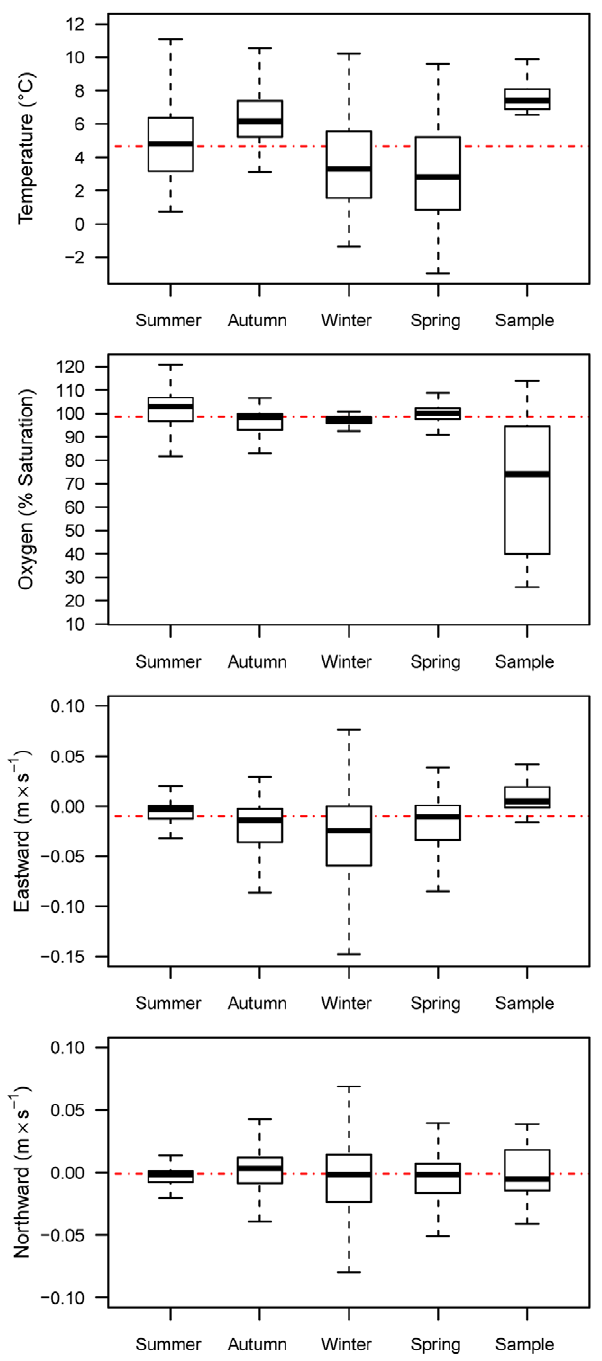
Figure 3. Boxplots of seasonally varying background and observed covariates. Median (closed bar), 1 st and 3 rd quartile (rectangle) and range (whisker) for background samples by season (first four boxplots), and for presence samples (last boxplot on the right). The red dashed line in each panel represents the overall median.